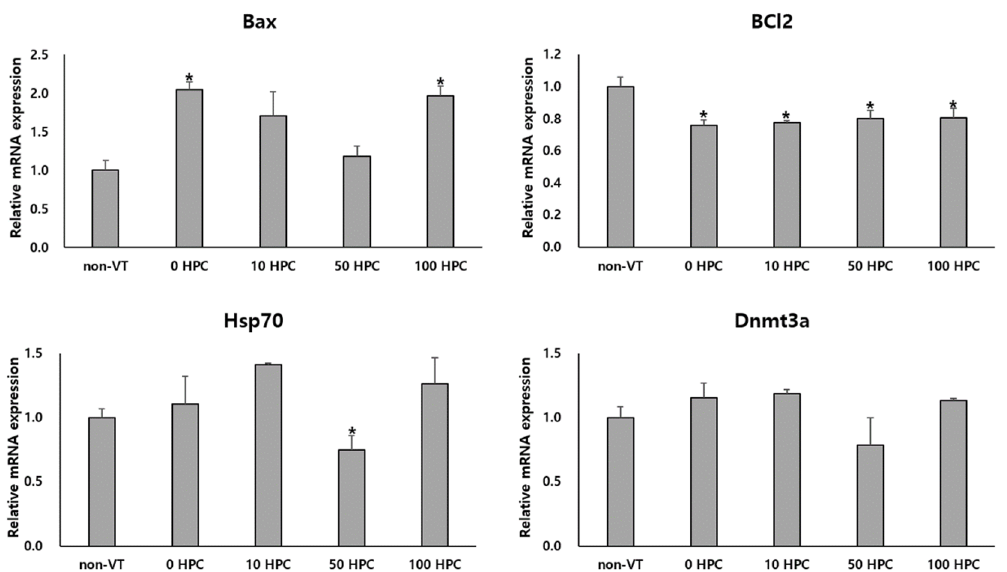
Figure 3. Relative mRNA expression levels of genes related to apoptosis (Bax and Bcl2), demethylation (Dnmt3a), and stress (Hsp70) in non-VT and VT oocytes. * p < 0.05 compared with the non-VT group.